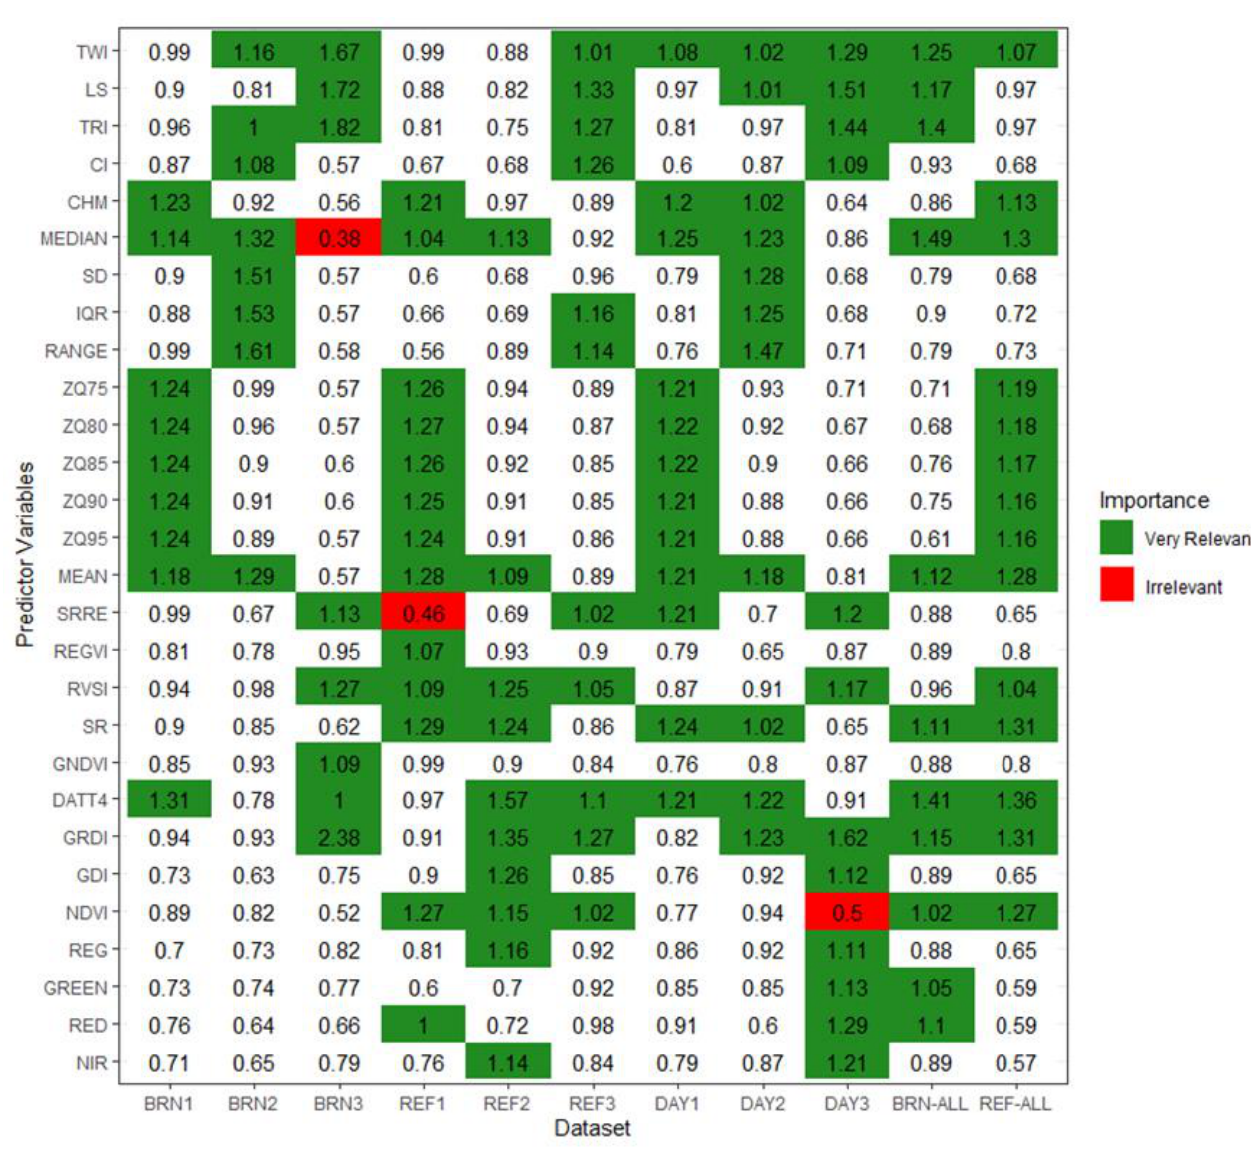
Figure 6. The variable influence on projection (VIP) scores for all spectral indices and Structure-from-Motion-derived metrics used as predictor variables in the partial least squares regression model. VIP values greater than 1 indicate the most relevant variables (highlighted in green), while VIP values less than 0.5 are considered irrelevant in the model (highlighted in red).